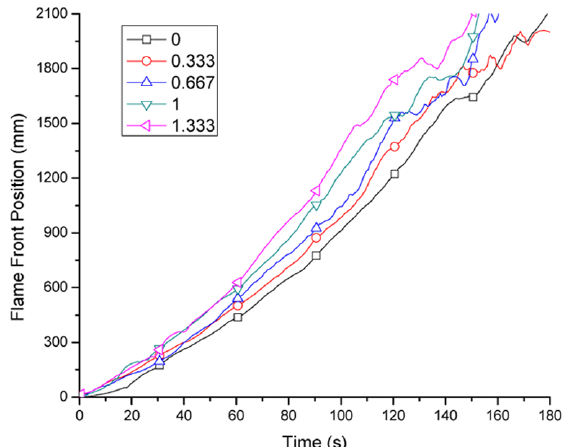
Fig. 4. 20 points smoothed average flame front position of each condition as a function of time (The symbols on each curve are only for visual identification